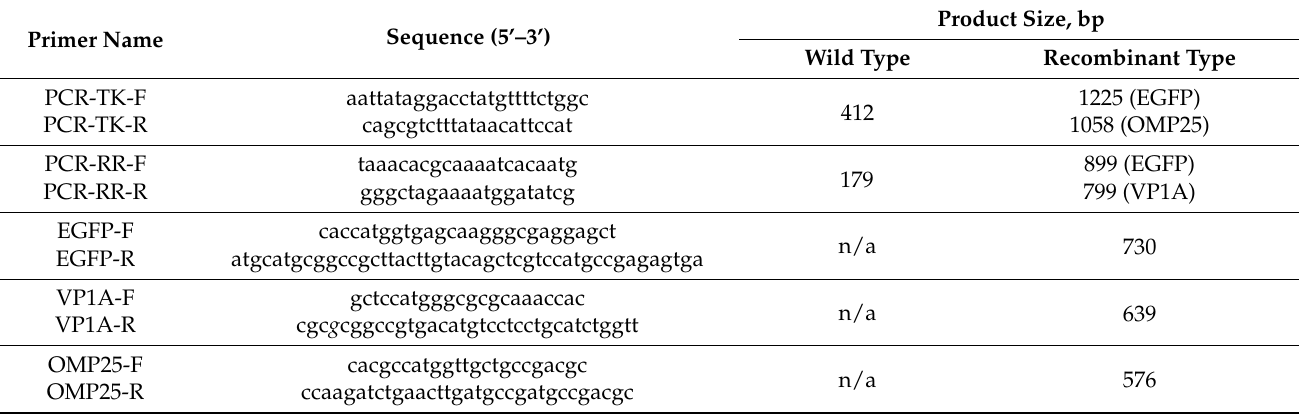
Table 2. Primers utilized for recombinant viruses’